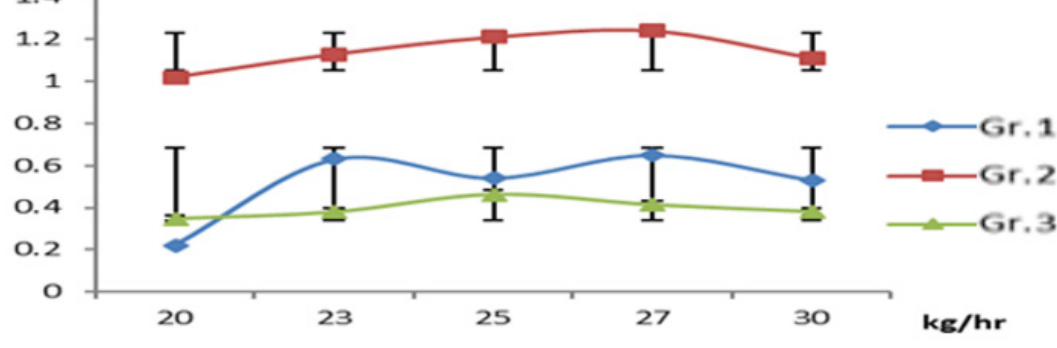
Figure 3. Effect of screw speed on dE* for Grade 1, Grade 2 and Grade 3.